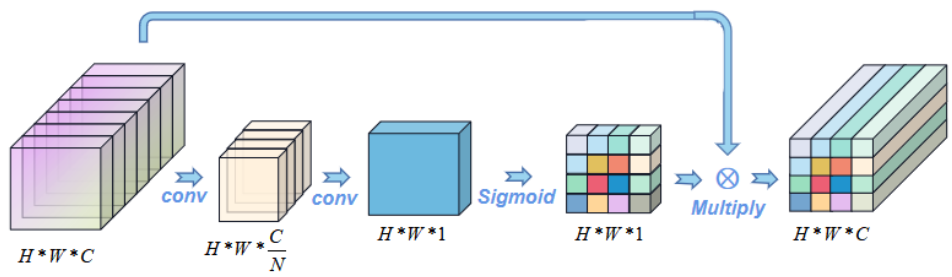
Figure 2. Spatial attention mechanism.